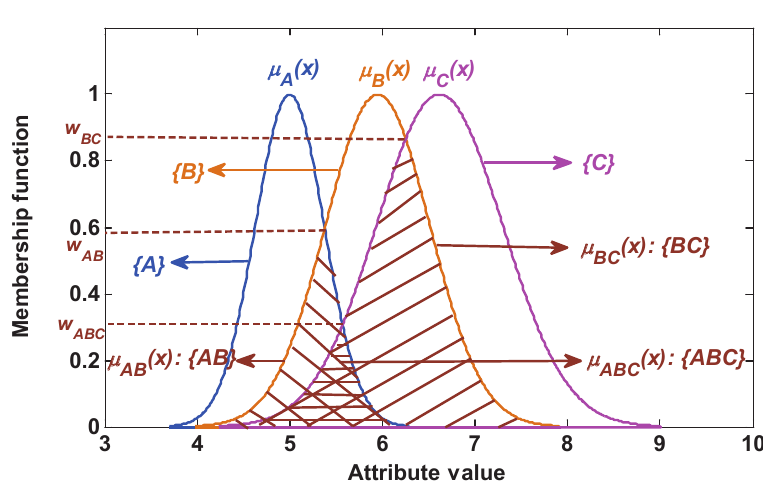
Figure 2. The modeling of the singleton subset and compound